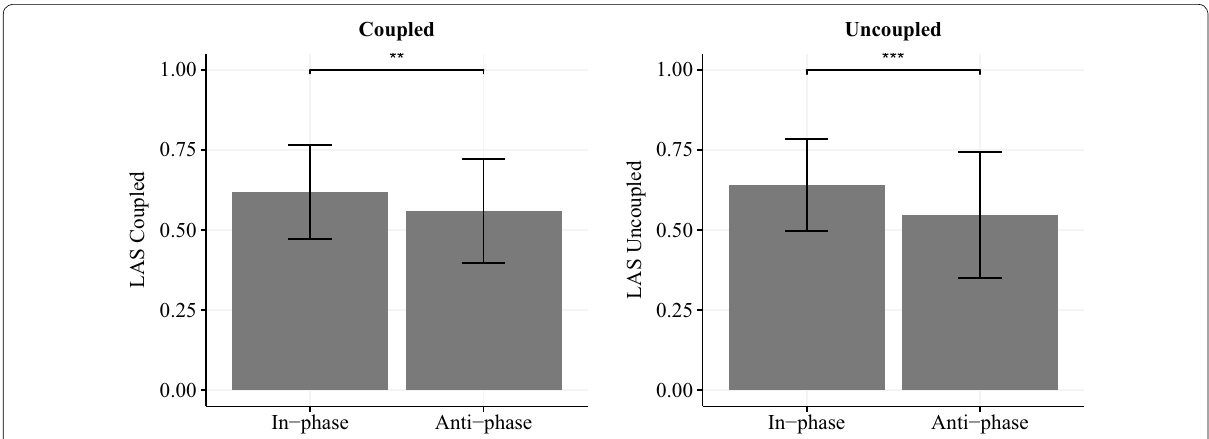
Fig. 7 Lateral activation similarity (LAS) indicates that the contralateral similarity in EMG signals measured for anti-phase motion is lower than that measured for in-phase motion in both coupled and uncoupled tasks. The whiskers represent ±